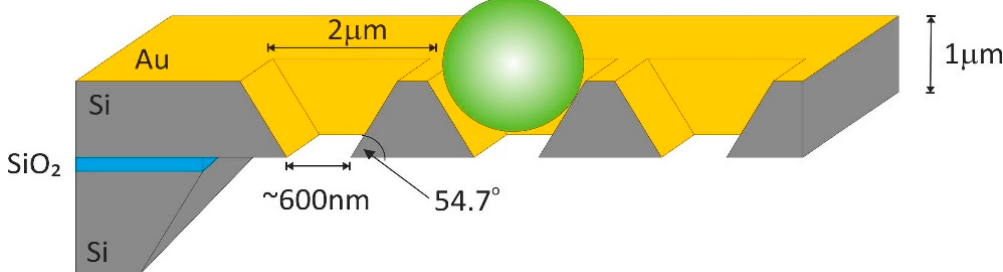
Figure 1. Schematic representation of the flow-through surface-enhanced Raman scattering (SERS) substrate with an entrapped microsphere.